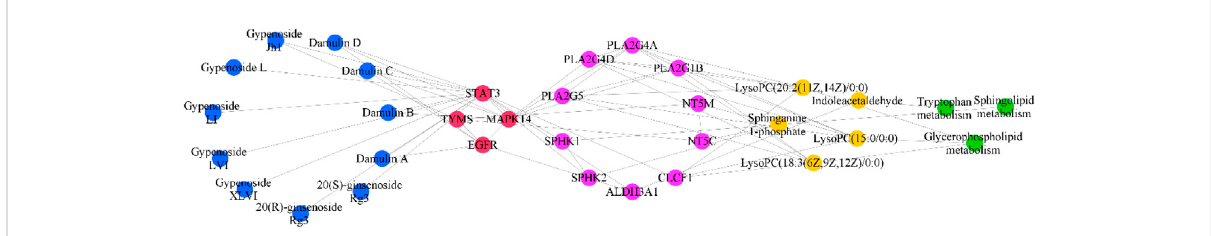
FIGURE 10 Compound-intersection gene-metabolite related gene-metabolites-pathway network. Blue nodes, red nodes, purple nodes, yellow nodes, and green nodes represented 11 components of GYP, intersection targets of components and diseases, metabolite related targets, differential metabolites of GYP recovery, and metabolic pathways, respectively.